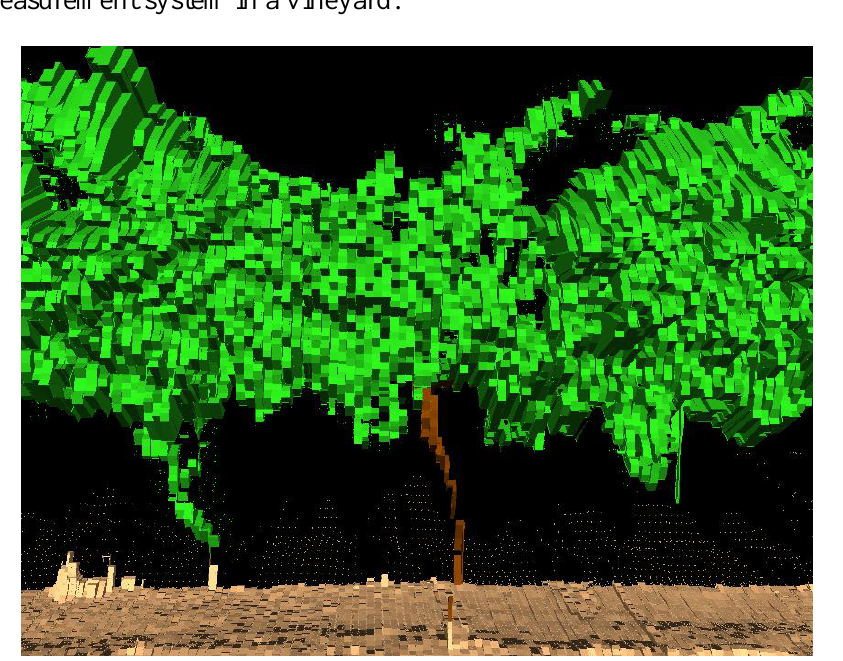
Figure 2. Resulting volume after processing the point cloud obtained with a 2D TLS dynamic measurement system in a